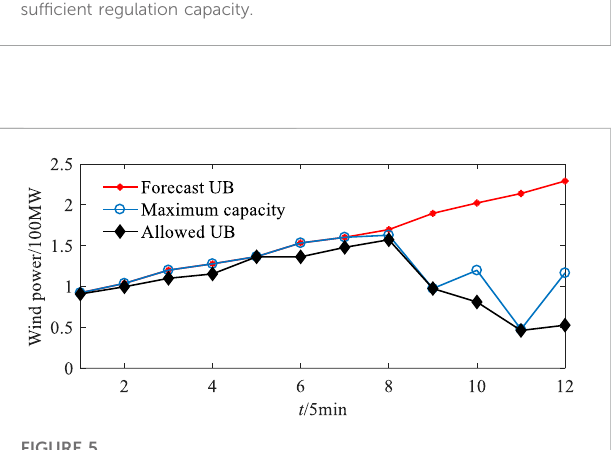
FIGURE 4 Allowed upper bound (UB) of wind fl uctuation in the system with suf fi cient regulation capacity.